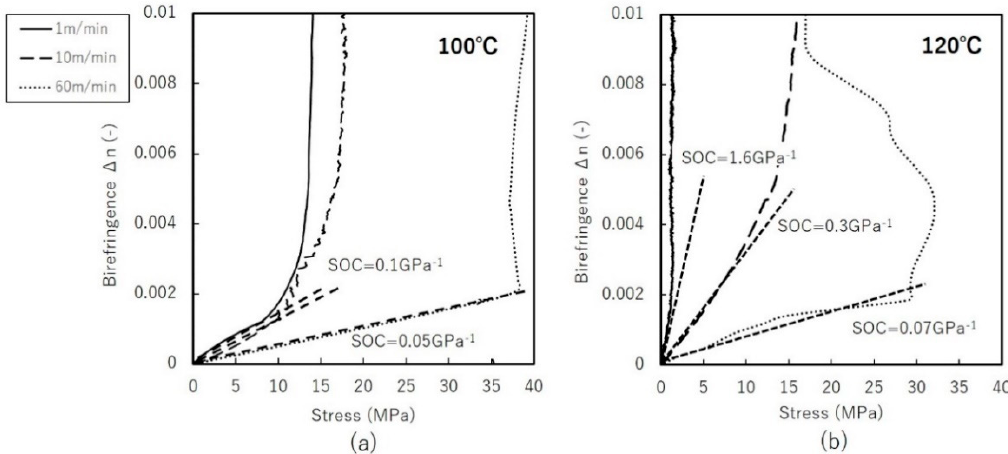
Figure 7. Birefringence vs. true stress of uniaxial constrained-width stretching at: ( a ) 100 °C ( b ) 120 °C.